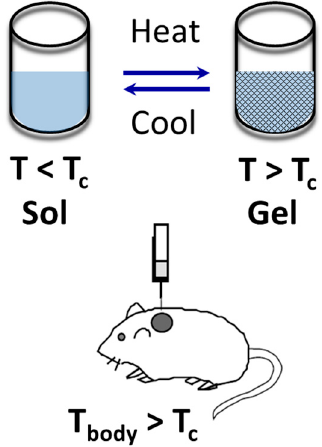
Figure 6. Sketch of subcutaneous injection of drug-delivery hydrogel containing bioactive molecules, with reversible sol–gel transition around the LCST point. T c is the coil–globular critical temperature of a LCST hydrogel. Adapted with permission from reference [81]. Copyright © 1997 Nature Macmillan Publishers Ltd. (Basingstoke, UK) 1997.